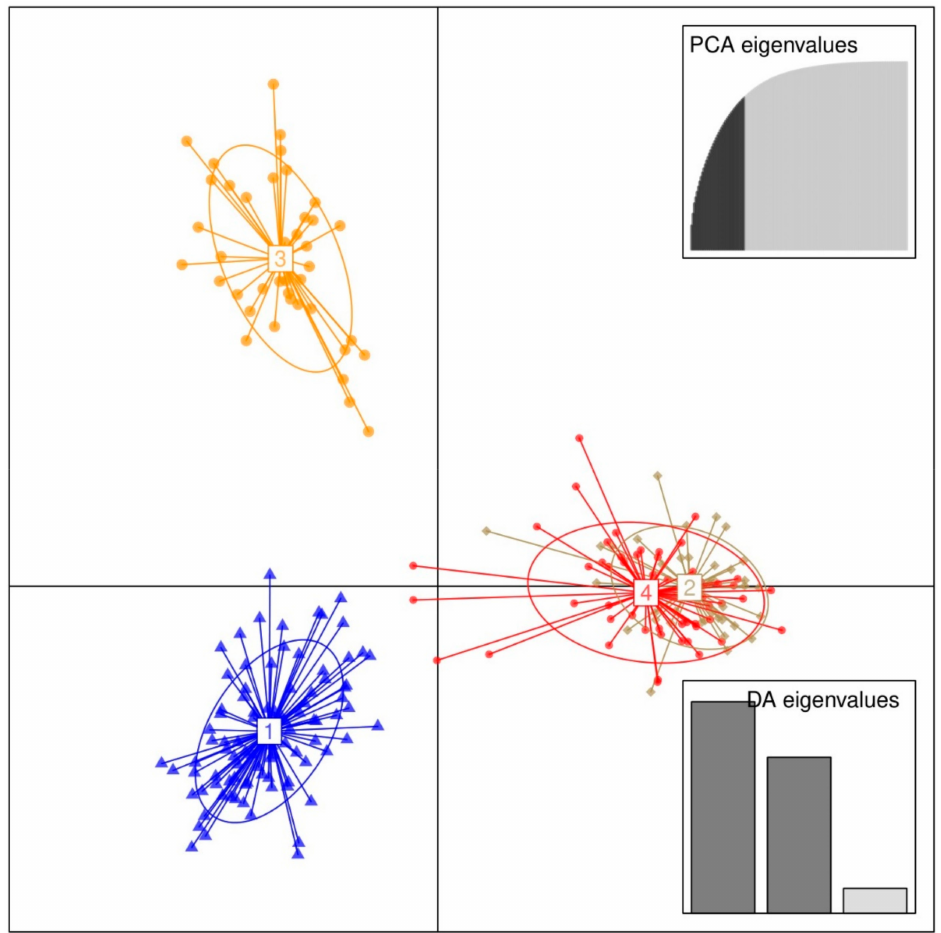
Figure 4. Discriminant analysis of principal components (DAPC) for 226 avocado samples. The axes represent the first two Linear Discriminants (LD). Each circle represents a cluster, and each symbol represents an individual. Numbers represent the different subpopulations identified by